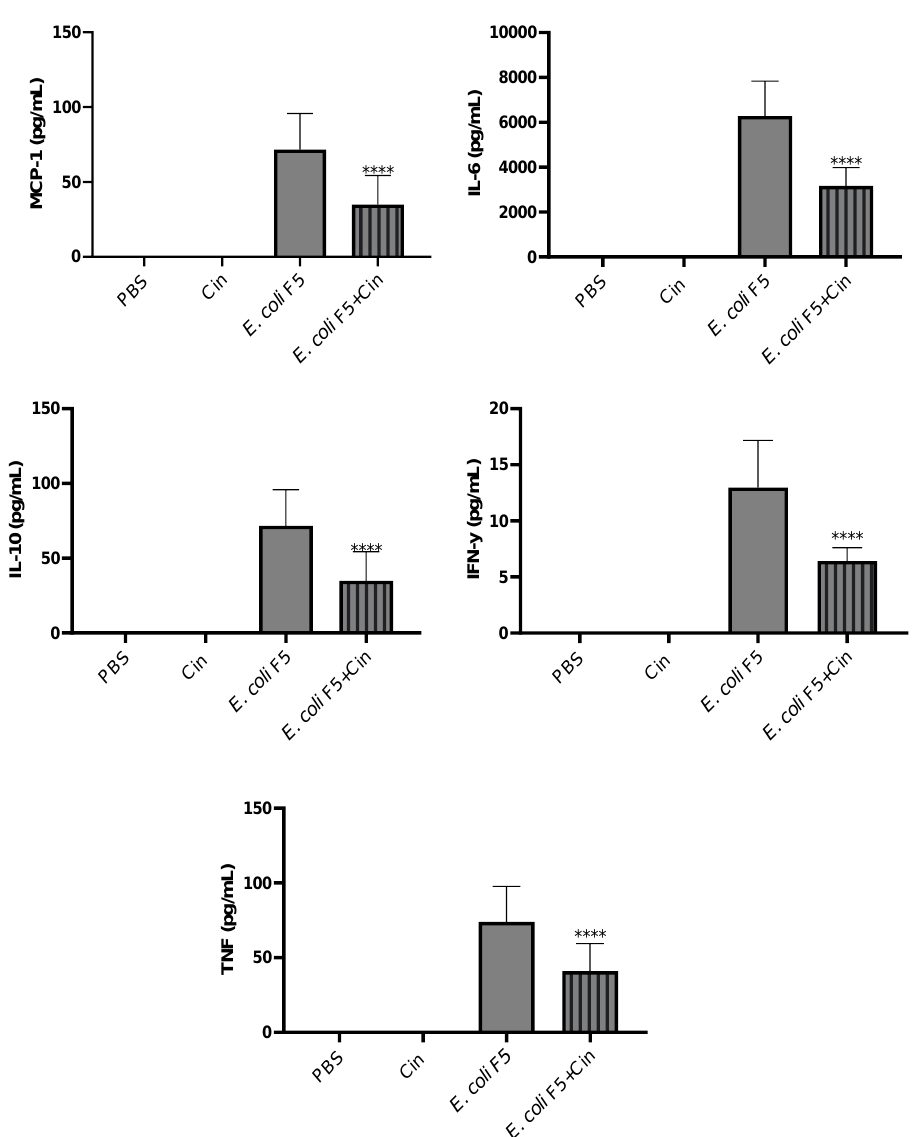
Figure 9. Detection of cytokines in the peritoneal lavage of animals infected with E. coli F5 and cinnamaldehyde treatment. Ten hours after peritoneal inoculation of E. coli F5, animal peritoneal lavages were used for cytokines dosage by flow cytometry. The results represent the mean ± S.D. of 6 animals/group. **** p < 0.0001 as compared with the E. coli F5 group.